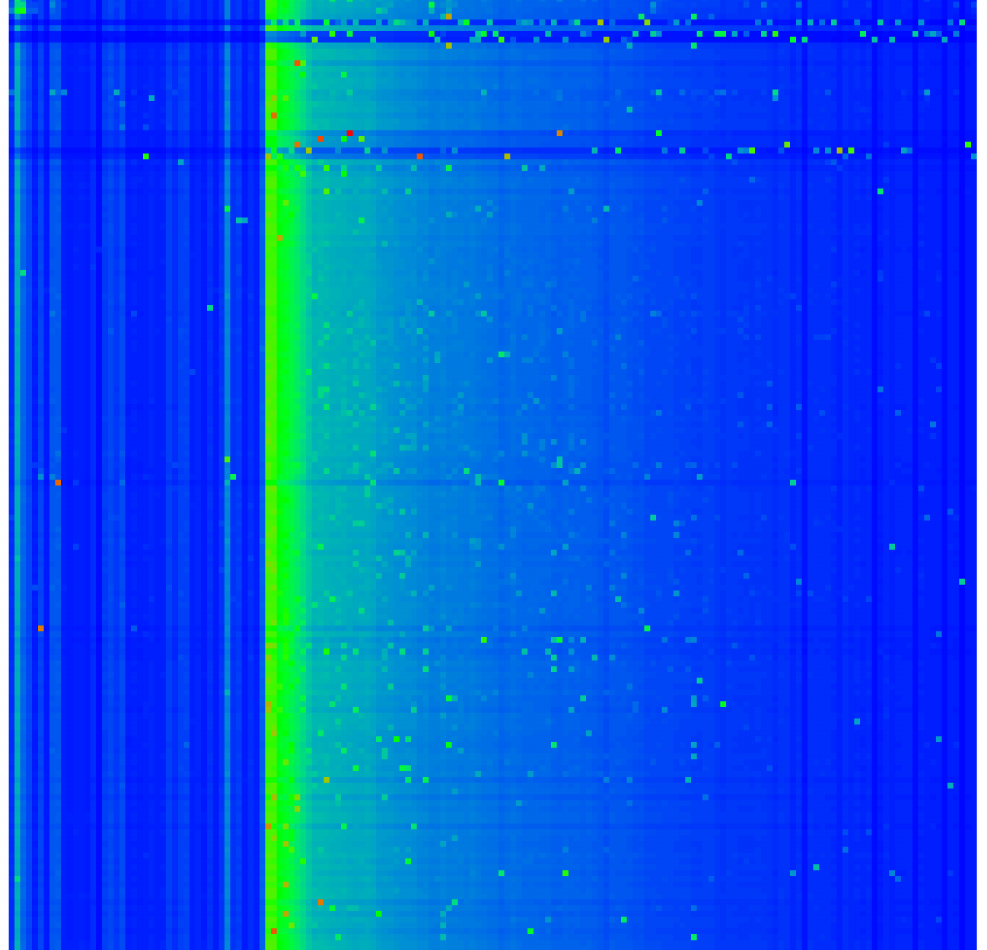
( 166 ) for the intermediary group of ab